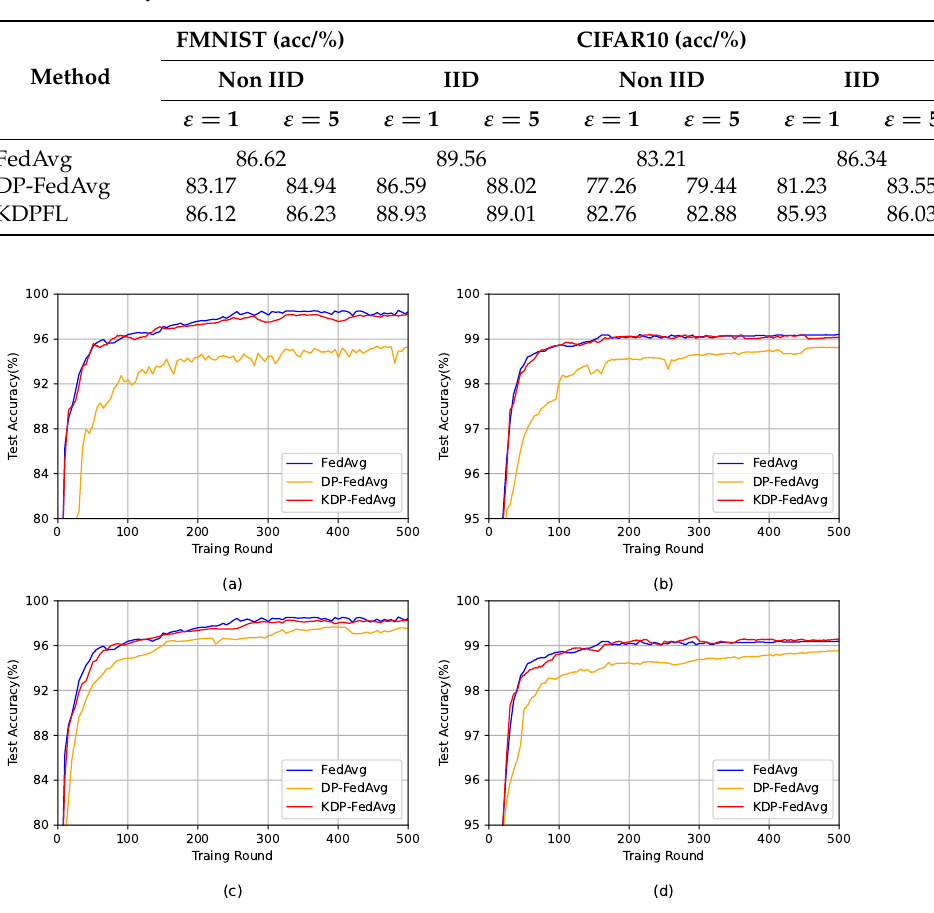
Figure 3. Experiment results: ( a ) non-IID, ε = 1; ( b ) IID, ε = 1; ( c ) non-IID, ε = 5; ( d ) IID, ε =